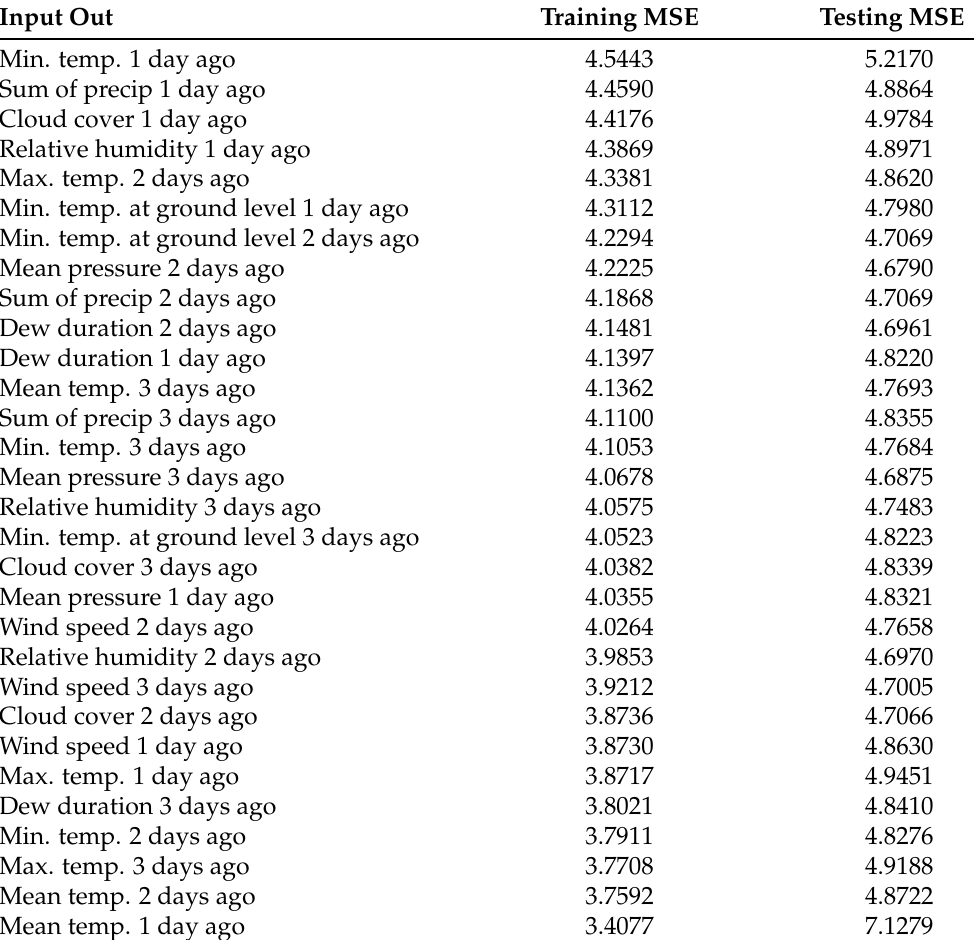
Table A3. The results of the sensitivity analysis for the prediction of the minimum daily temperature.